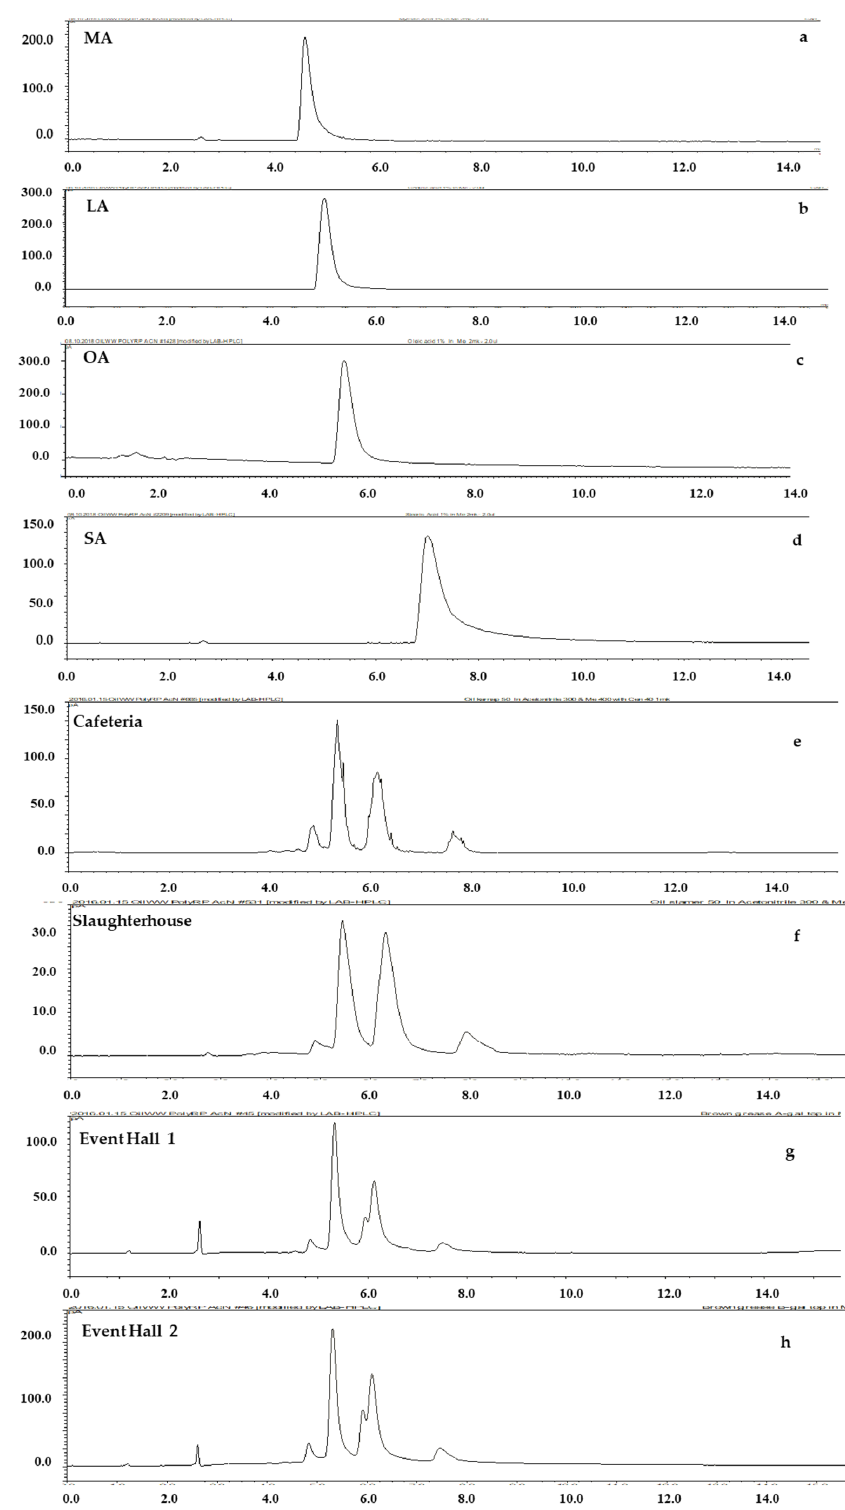
Figure 2. HPLC chromatograms of commercial free fatty acid (FFA) standards: ( a ) myristic acid (MA), ( b ) linoleic acid (LA), ( c ) oleic acid (OA) and ( d ) stearic acid (SA), and of the fatty phase of brown grease from four different sources: ( e ) cafeteria, ( f ) slaughterhouse and ( g , h ) two event halls.